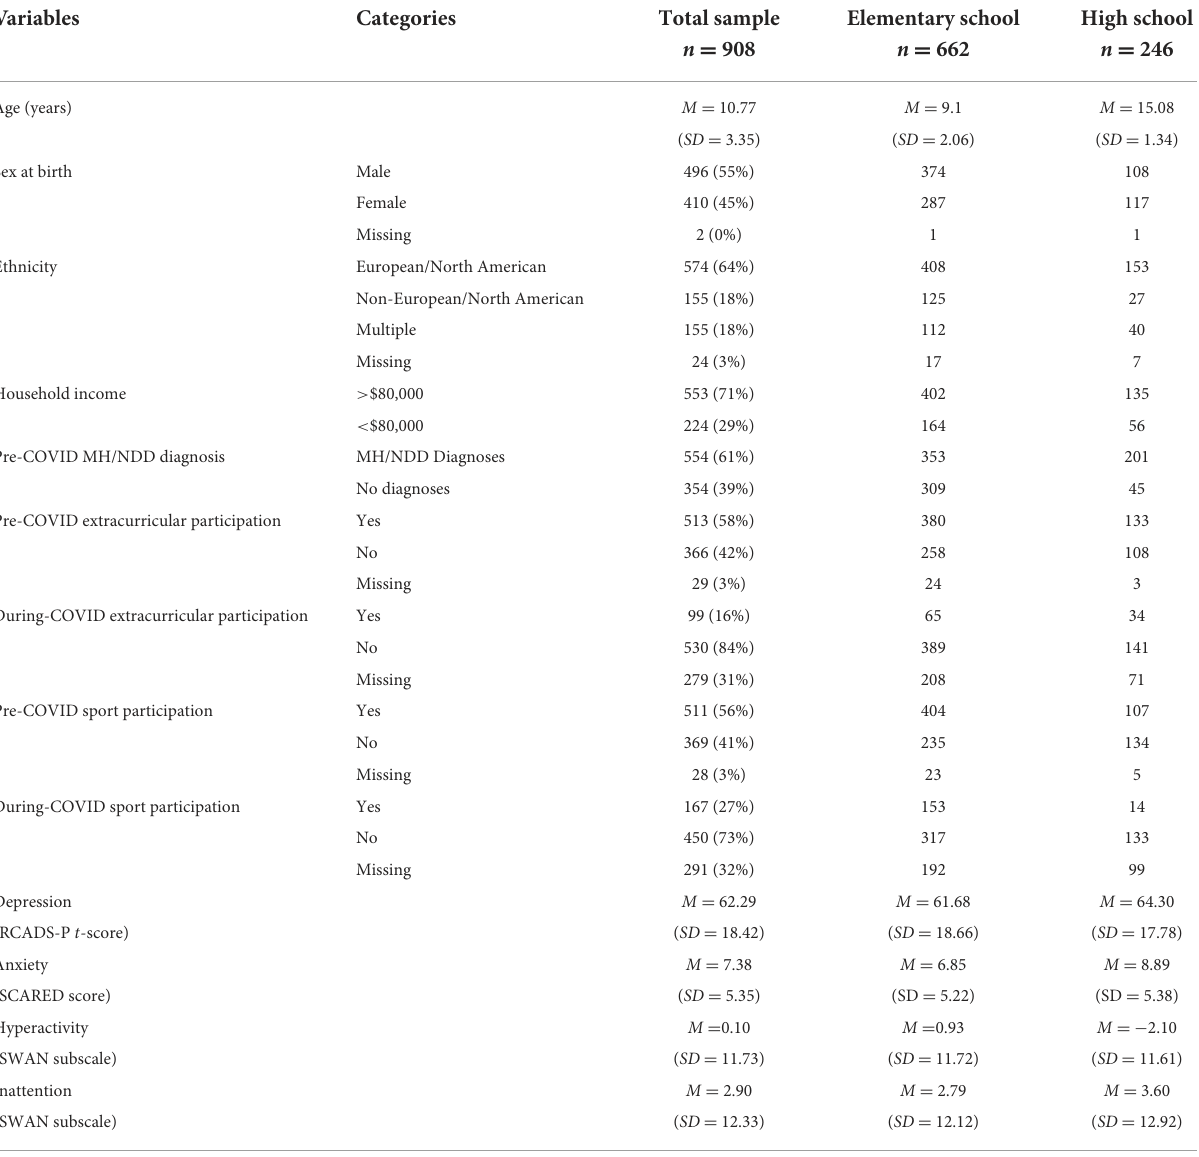
TABLE 1 Sample characteristics and demographics and mean mental health scores of children and youth by parent-reported